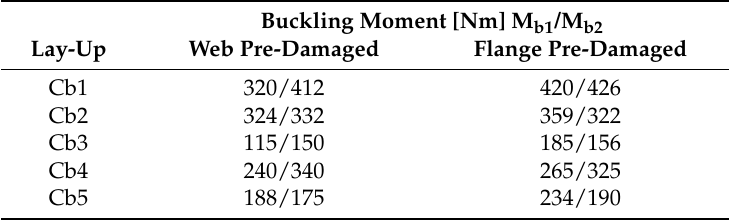
Table 3. Buckling bending moments.